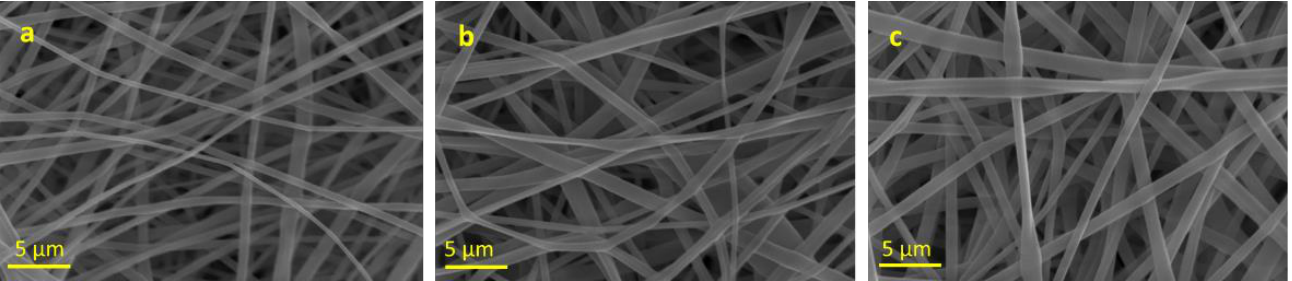
Figure 2. SEM images of PLA fibers in DCM/DMF (9:4 v / v ): ( a ) 7% PLA; ( b ) 7.5% PLA; ( c ) 8% PLA. Average fiber diameters are: ( a ) 0.76 ± 0.13 µm; ( b ) 0.94 ± 0.28 µm; ( c ) 0.95 ± 0.30 µm. To incorporate the AgNPs, 87.3 mg of AgNO 3 was dissolved in 4 mL of DMF at room temperature. The solution was left stirring in the dark for 30 min while the color turned to bright yellow. Meanwhile, a solution of 1.184 g of PLA in 9 mL of DCM was prepared. At to electrospinning. The final composition of the spinning solution was: DCM/DMF 9/4 ( v / v ), PLA 7 wt.%, Ag 4.7 wt.% (with respect to